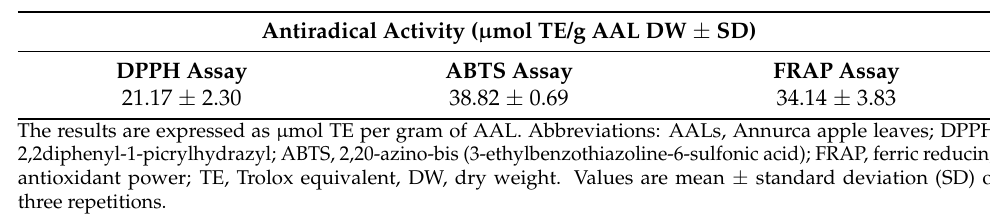
Table 4. Antiradical activity of AAL extract evaluated by DPPH, ABTS, and FRAP assays.